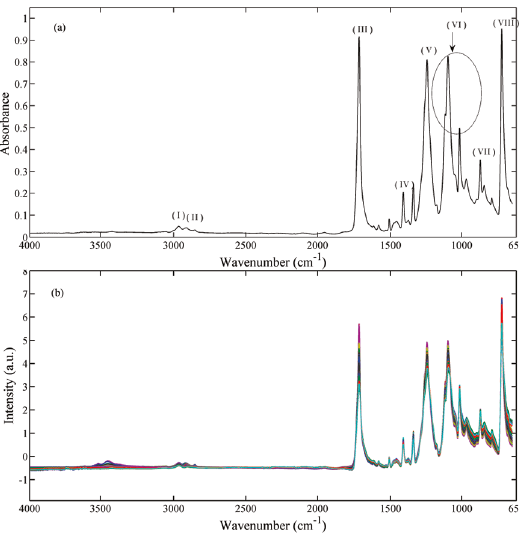
Figure 9. (a) Mean MIR raw spectra before chemical attack and (b) after exposure to NaOH (pre-processed with SNV).